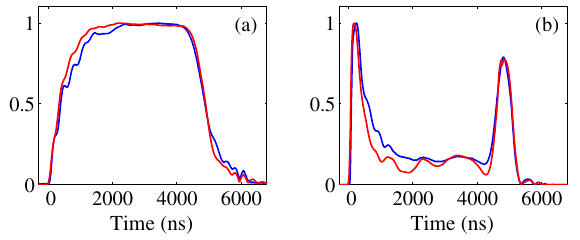
FIG. 9. Comparison of simulation (red line) and experimental results (blue line) without breakdown. (a) Normalized pickup signal. (b) Normalized reflection signal.